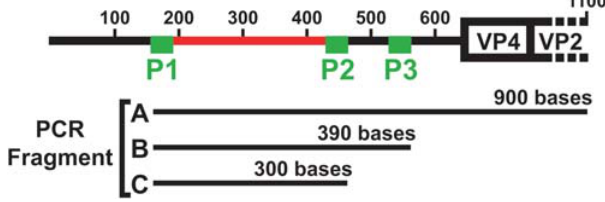
Figure 1. Schematic representation of the first 1100 base of a HRV genome showing the locations of the highly conserved regions (P1, P2 and P3) and variable region between P1 and P2 (P1-P2 in red) at the 5’NCR and the PCR fragments used in this study. P1, P2 and P3 are located at bases 163–181, 443–463 and 535–551, respectively in HRV16 genome. PCR fragment A (about 900bps) was used to determine the 5’NCR sequences of all 101 HRV serotypes. It was amplified using pan-HRV PCR forward primer P1-1, which anneals to conserved region P1, and a serotype-specific reverse primer annealed to the 5’ end of VP2 gene (between base # 1000 and 1100). PCR fragment B (about 390 bps) was generated with pan-HRV PCR forward primer P1-1 and reverse primer P3- 1. PCR fragment C (about 300 bps) was generated with forward primer